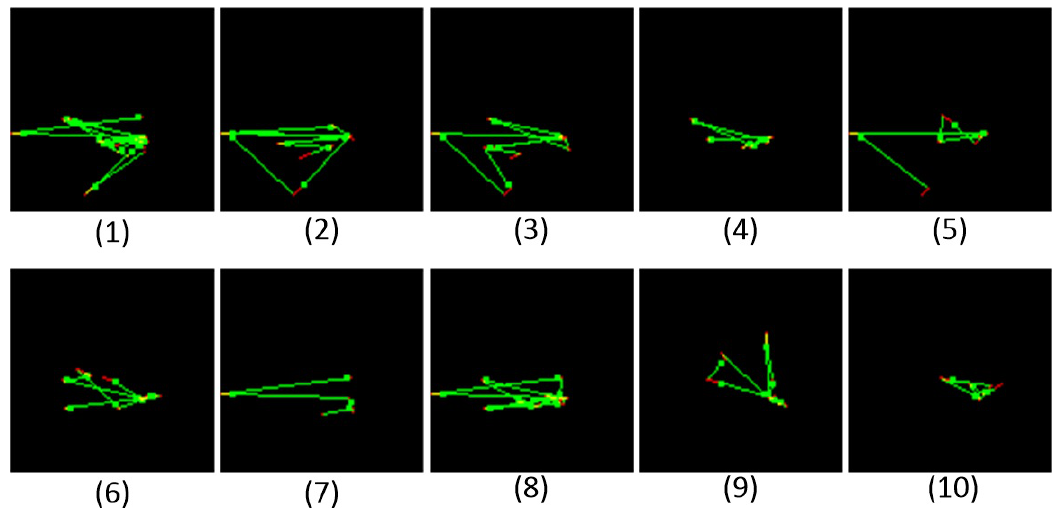
Figure 7. An example of 10 narrative pixel images generated from the item “EVENT_ID_NO_CNTY” 53,233 to